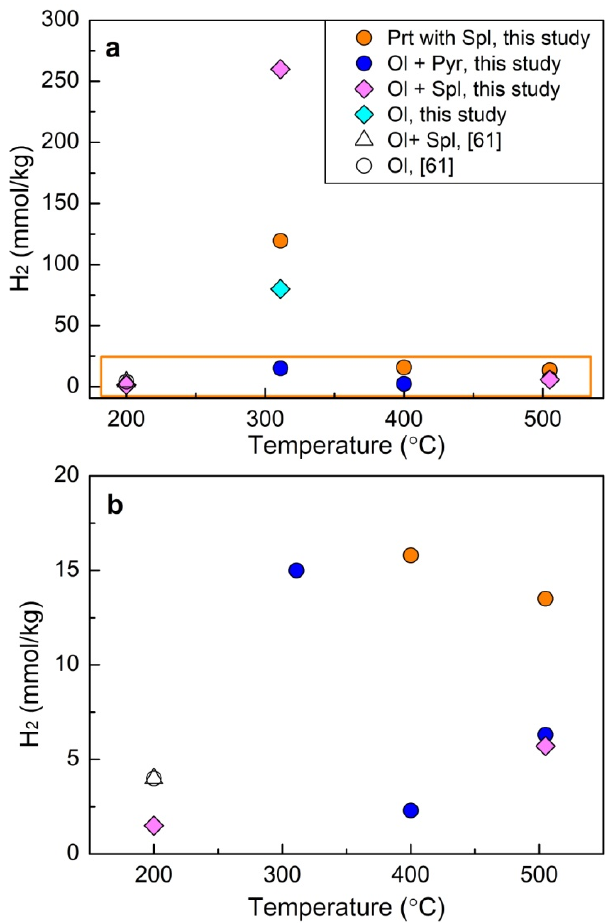
Figure 5. ( a ) Temperature dependence of the influence of spinel and pyroxene minerals on H 2 production during serpentinization. ( b ) An enlargement of the yellow rectangle in ( a ). Ol: olivine, Pyr: pyroxene, Spl: spinel, Prt: peridotite.